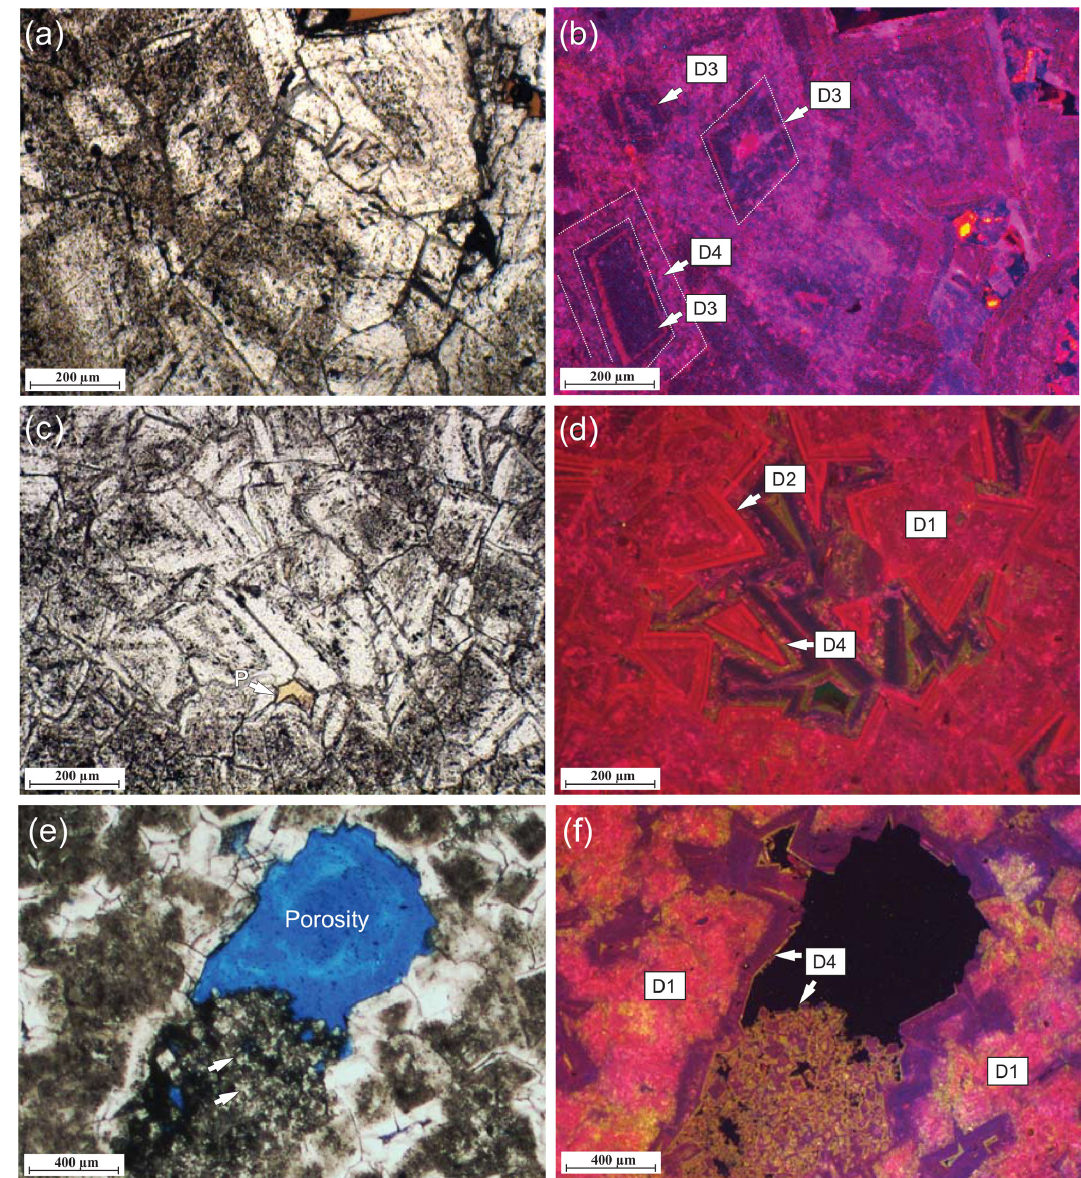
Figure 8. Photomicrographs from transmitted light and corresponding cathodoluminescence of dolomite types. (a, b) The cross-cutting relationship between D3 and D4 sampled from dolomitized Corniola Formation in Osso Caprino road is shown. Note the presence of D3 within the core of dolomite crystals overgrown by D4. (c, d) Successions of dolomite types sampled from dolomitized Calcare Massiccio Formation in field site f. Note the green CL color of D4 crystals. Typically, luminescent dolomites are known to show yellow or orange-to-red colors (Machel et al., 1991). Green luminescence in carbonates including dolomite have been attributed by a number of researchers to the incorporation of three valent rare-earth elements (REE) such as Dy 3 + and U 3 + as luminescence activators within their crystal lattice (Luczaj and Goldstein, 2000). Another possibility is the emplacement of Mn 2 + , with yellow luminescence, in Ca 2 + sites with blue luminescence in the dolomite crystal lattice instead of preferential incorporation in the Mg 2 + site (Sommer, 1972; Amieux, 1982; Walker et al., 1989; Habermann et al., 1999). Accordingly, non-stoichiometric Ca-rich poorly ordered dolomites may favor Mn + 2 incorporation into their Ca 2 + site. (e, f) Vuggy porosity rimmed by D4 (green CL). Note the porosity is filled with fine dolomite rhombs including traces of D2 in their core and D4